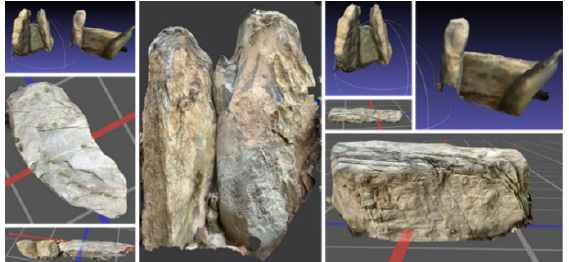
Figure 7. Textured meshes of a range of exposed structural stones from Dowth Hall, created using the iPad Pro in conjunction with the 3D Scanner App and